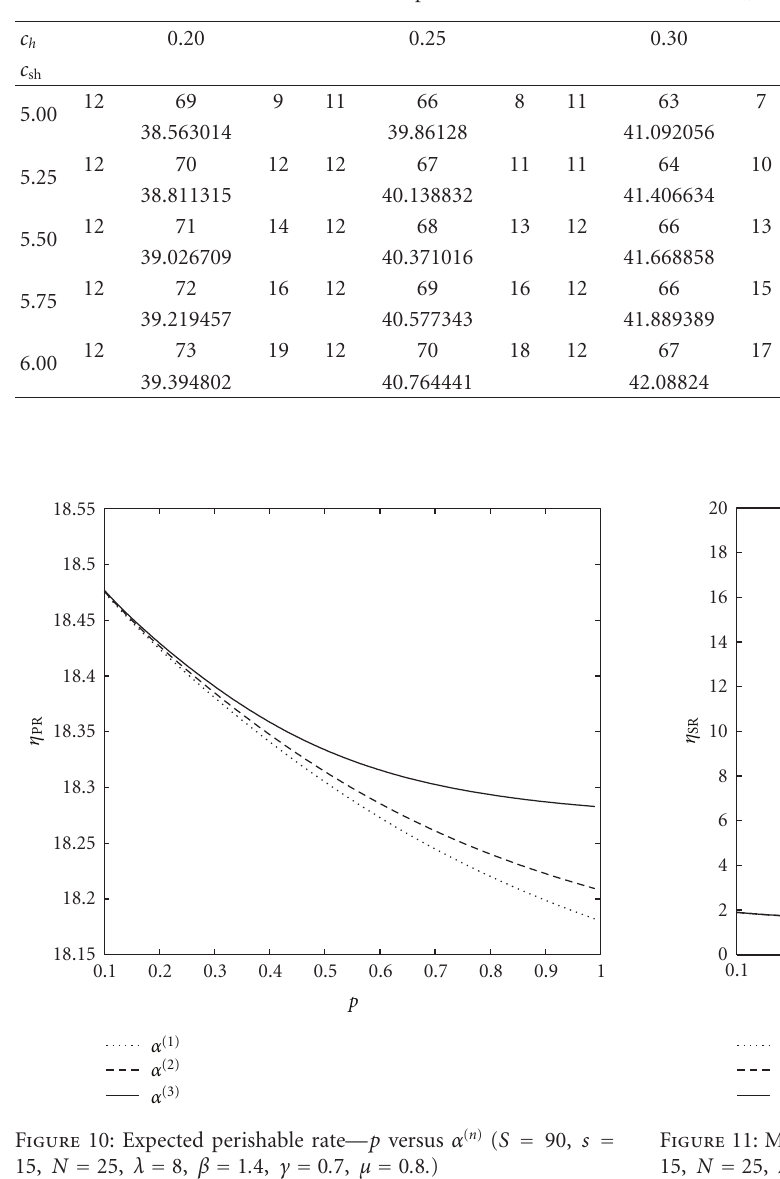
Table 14: Variation in optimal values for di ff erent values of c h and c sh ( c s = 15, c p = 3, c pr = 0 . 3).